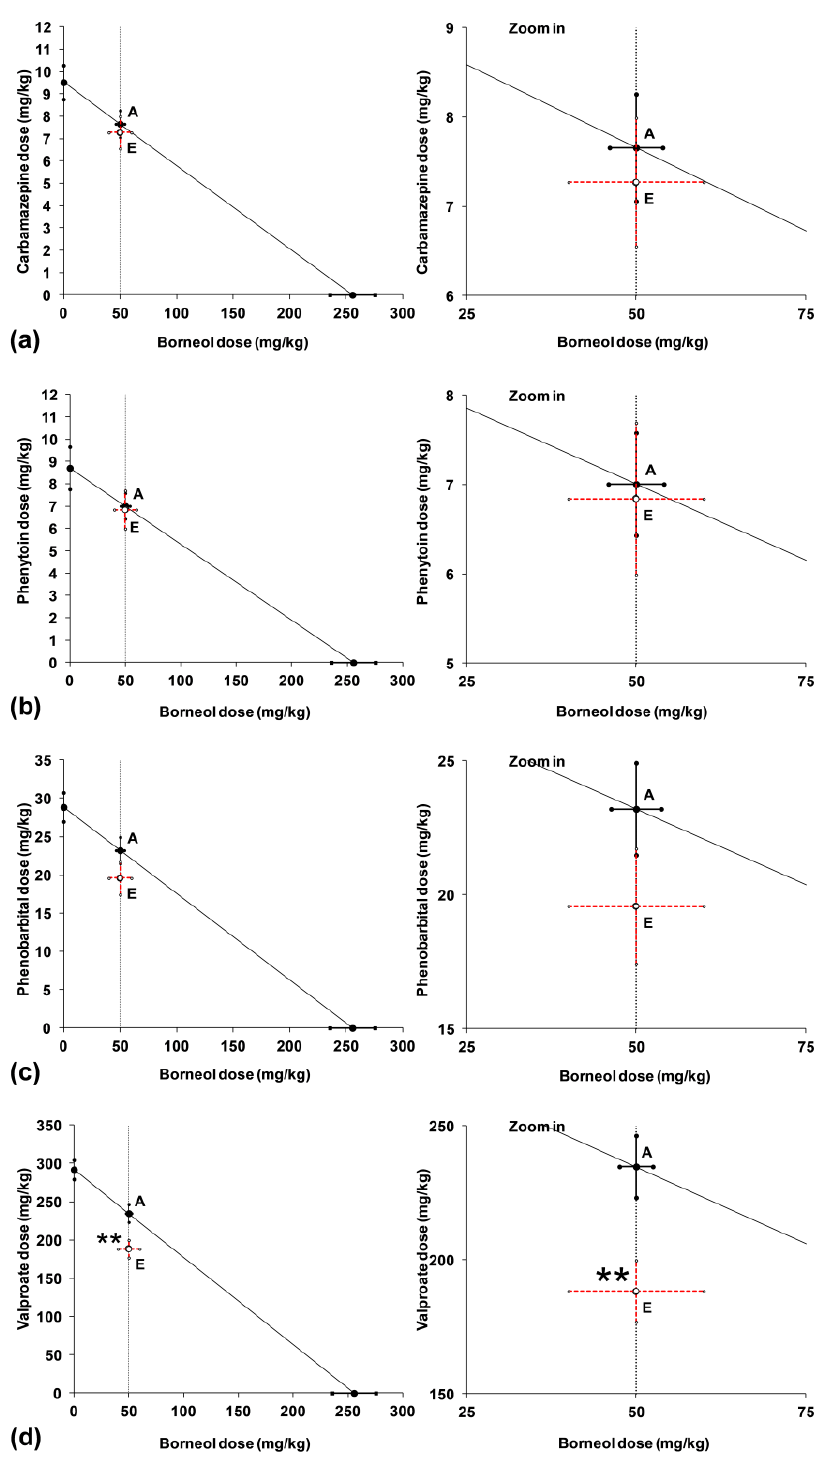
Figure 4. Isobolographic transformation of data for interactions between classic antiseizure medications and borneol in the mouse MES model. Interactions between borneol and carbamazepine ( a ), phenytoin ( b ), phenobarbital ( c ) and valproate ( d ) are plotted on isobolograms. The constant dose of borneol in mixture is parallel to the Y-axis. The oblique line connecting the ED 50 values of X- and Y-axes (as the line of additivity) represents the theoretically calculated ED 50add values. Point A reflects the theoretically calculated ED 50add value for the two-drug mixture (borneol + ASM), whereas the experimentally derived ED 50exp is illustrated graphically as point E. ** p < 0.01 vs. the respective ED 50add value for valproate + borneol (point A).